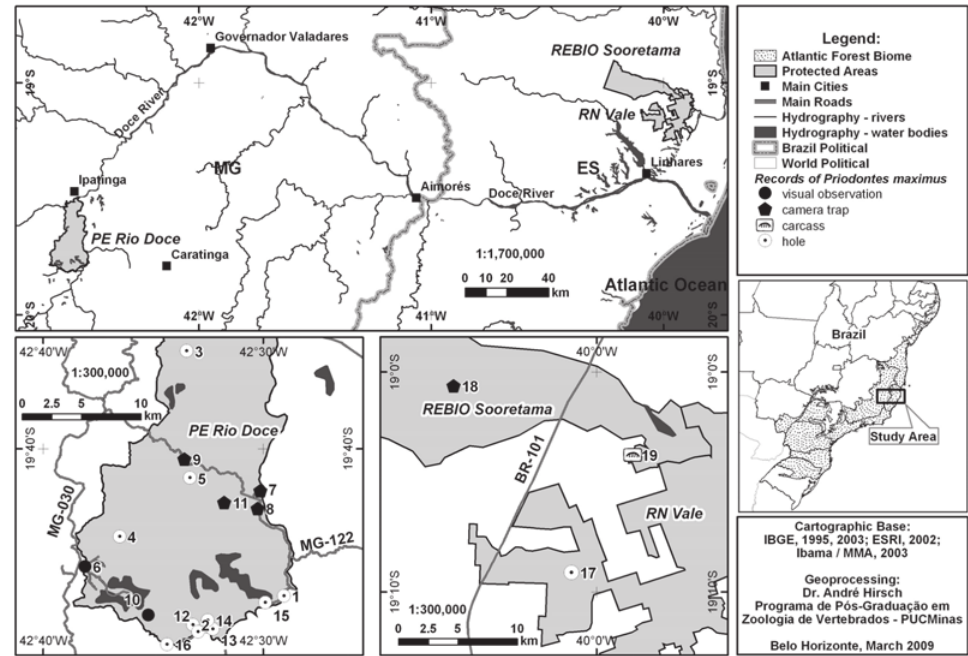
Figure 2. Records location of P. maximus in Parque Estadual do Rio Doce (PERD), Reserva Natural Vale (RNV) and Reserva Biológica de Sooretama (RBS) in southeastern